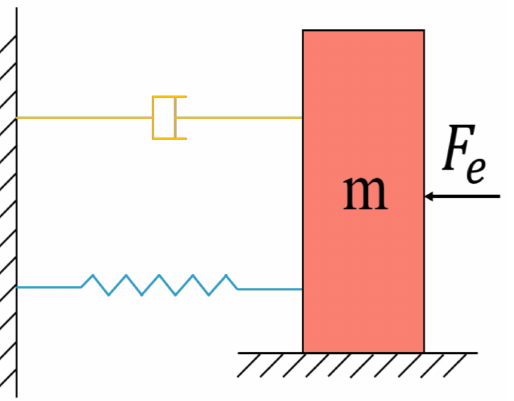
Figure 2. Schematic diagram of a single-degree-of-freedom, damped forced vibration